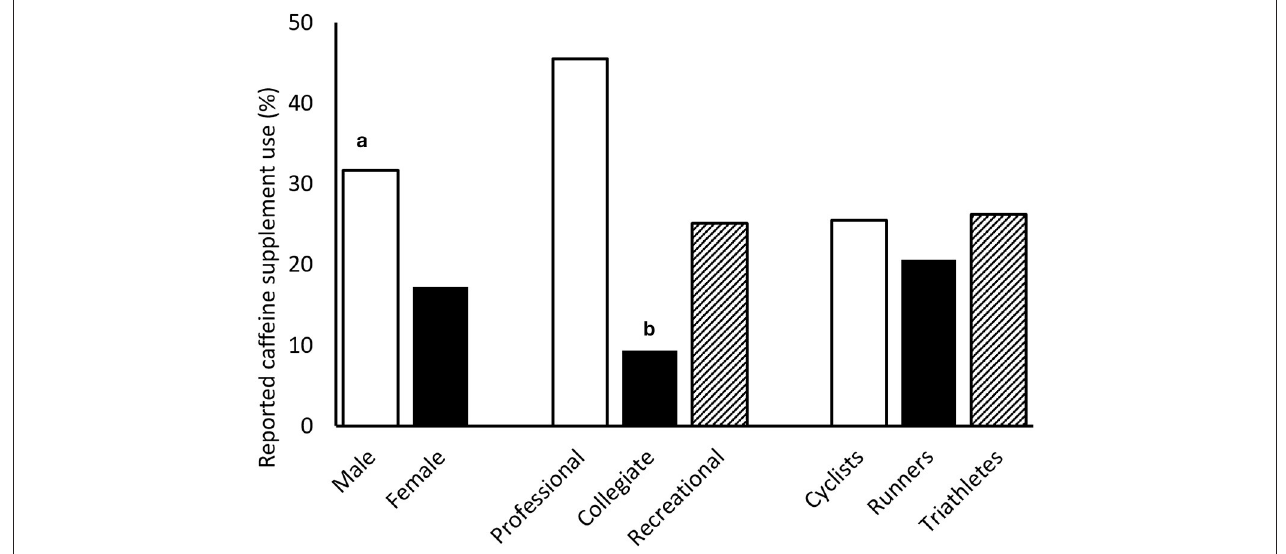
FIGURE 1 | Reported caffeine supplementation use by sex, athlete status, and primary sport. (A) Significantly greater than Female; (B) Significantly lower than Professional and Recreational.